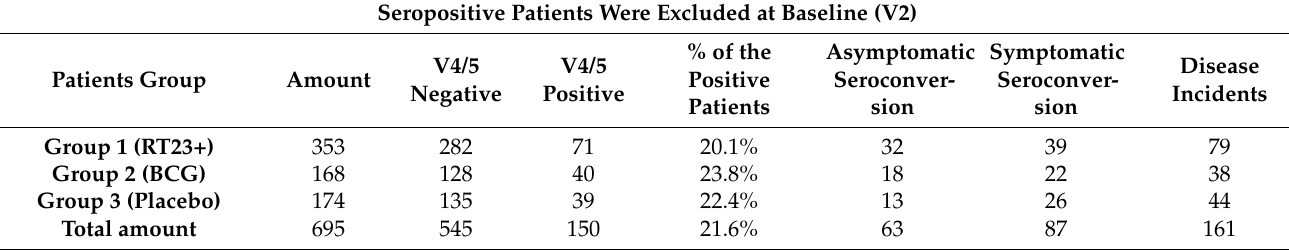
Table 11. Percentage of positive seroconversion among the treatment